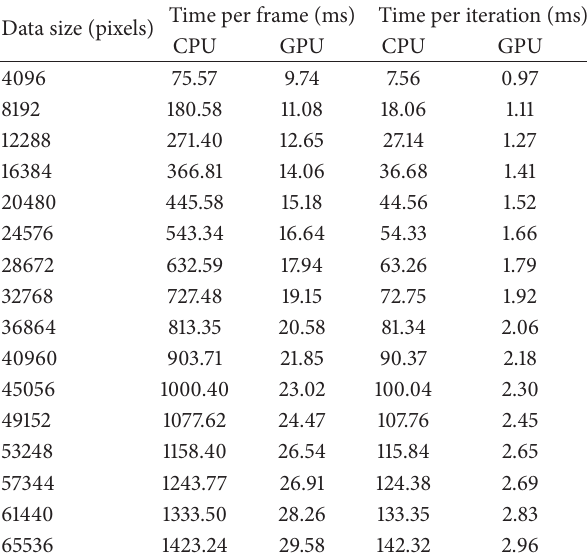
Table 1: The time per frame and the time per iteration of different data